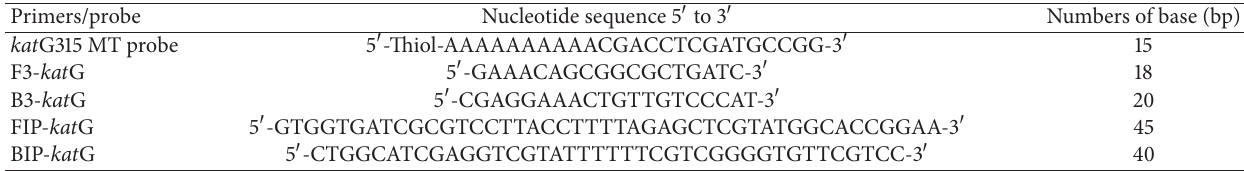
Figure 1: The directions and details of LAMP primers for amplification of a specific kat G gene of M. tuberculosis . Table 1: LAMP primers and Au-nanoprobe